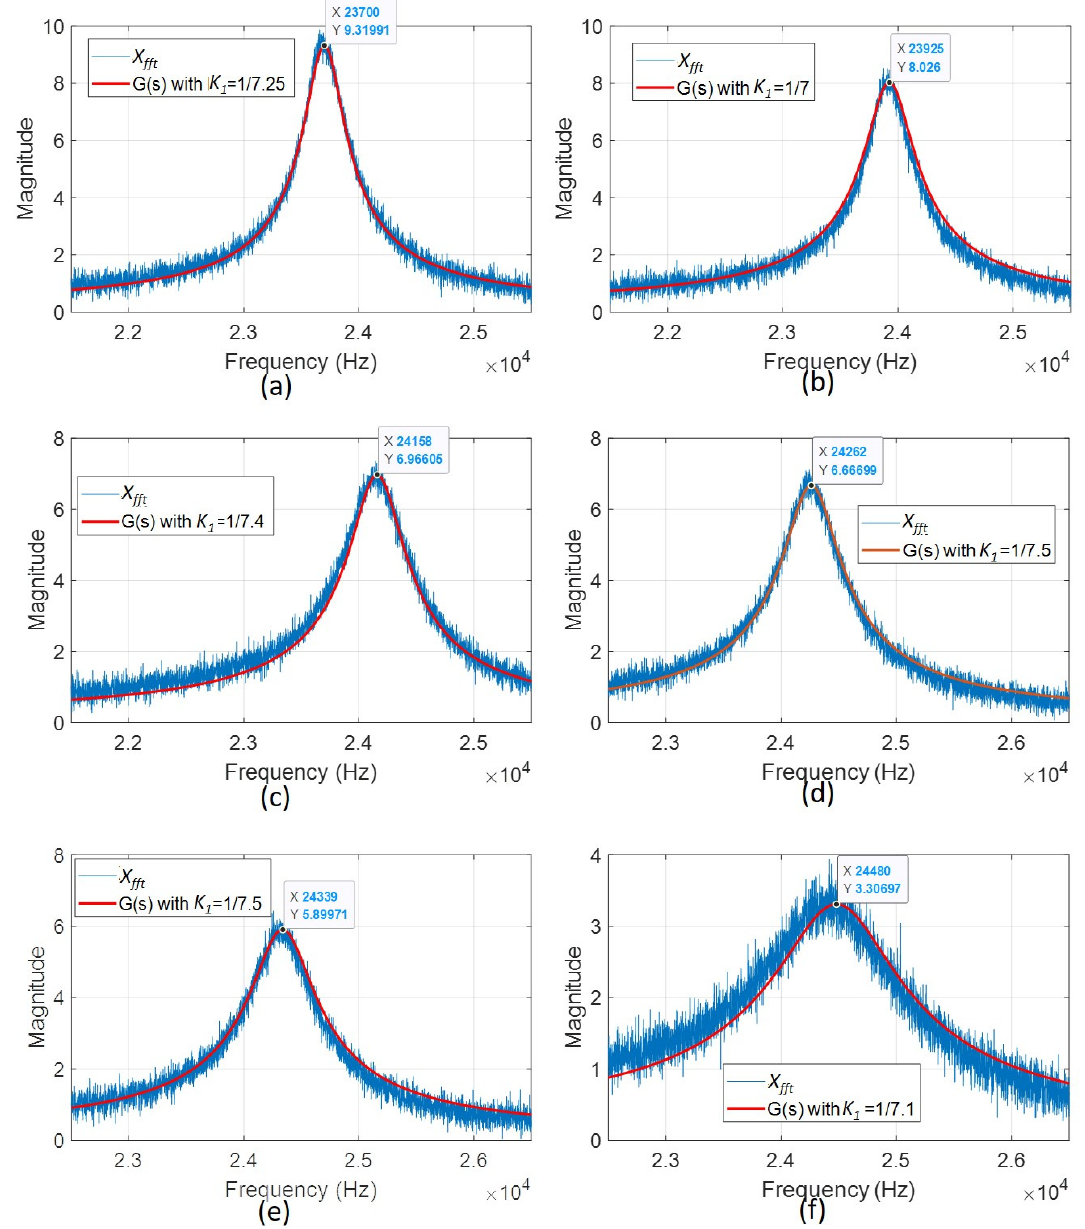
Figure 11. ( a ) The normalized frequency responses from X fft experimental results and their corresponding matching transfer functions G(s) : ( a ) the open-cavity case; ( b ) 1.5 mm; ( c ) 1.25 mm; ( d ) 1 mm; ( e ) 0.75 mm; ( f ) 0.5 mm cavity lengths.